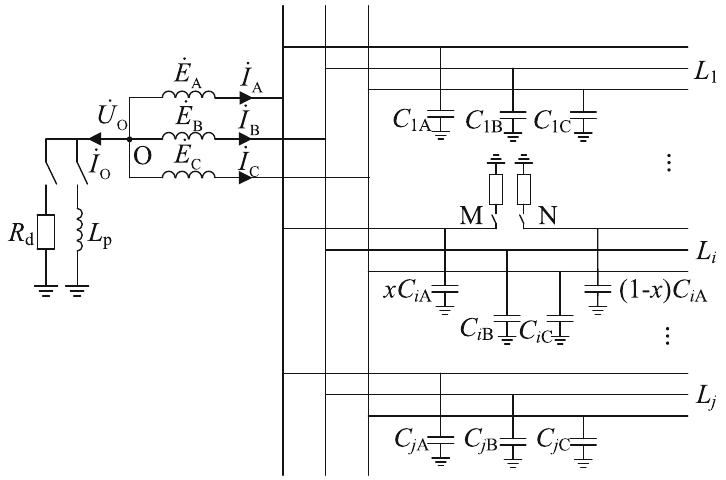
Fig. 1 Schematic diagram of distribution